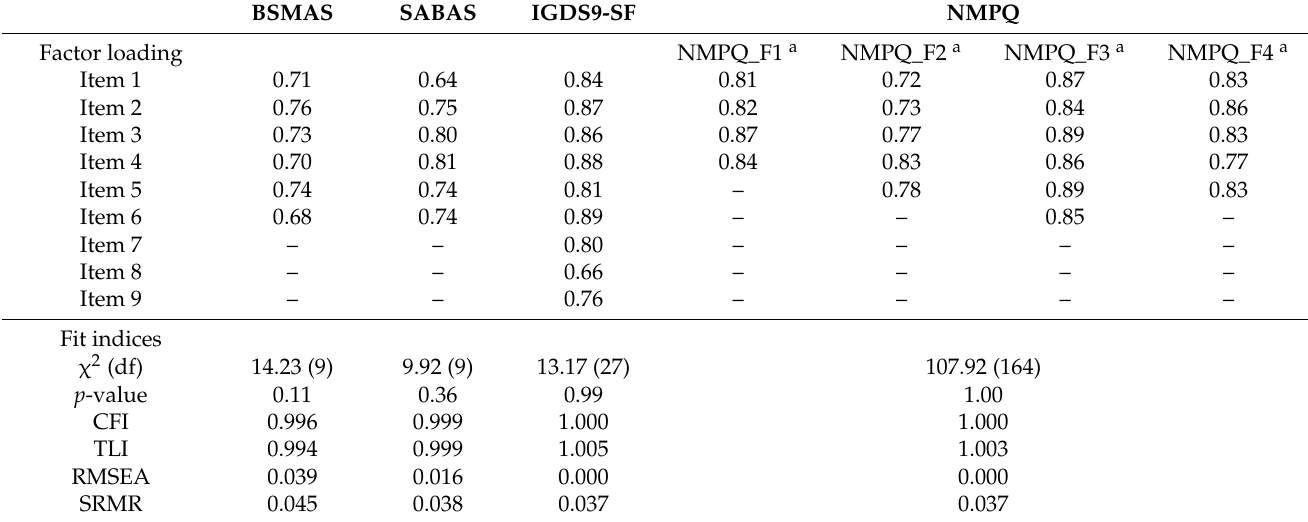
Table 3. Psychometric results derived from confirmatory factor analysis on the internet-related